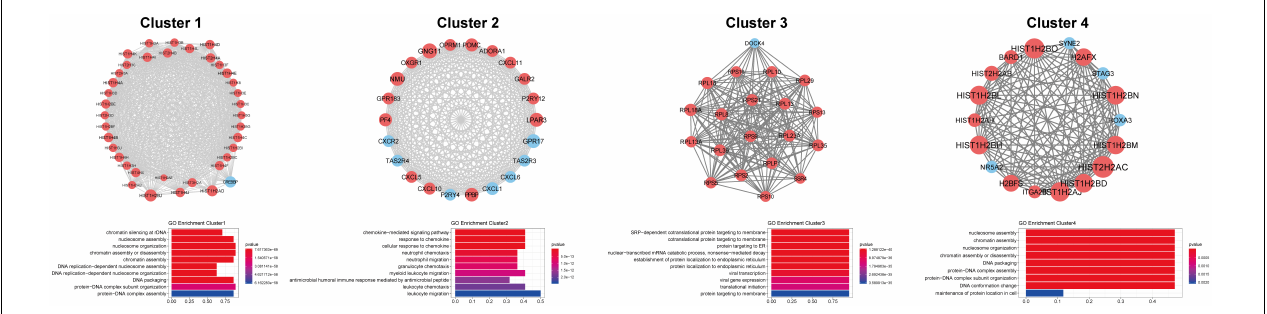
FIGURE 2 | Four PPI networks and biological processes enrichment results. Size of node represents degrees. Nodes with blue are downregulated, and those with red are